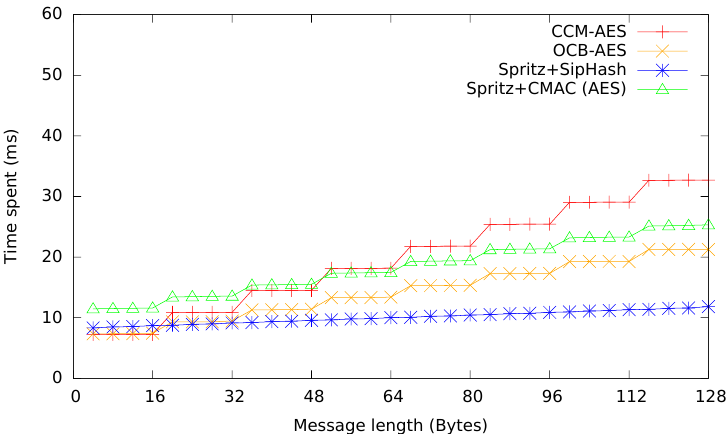
Figure 9. Modes compared with expected Spritz +